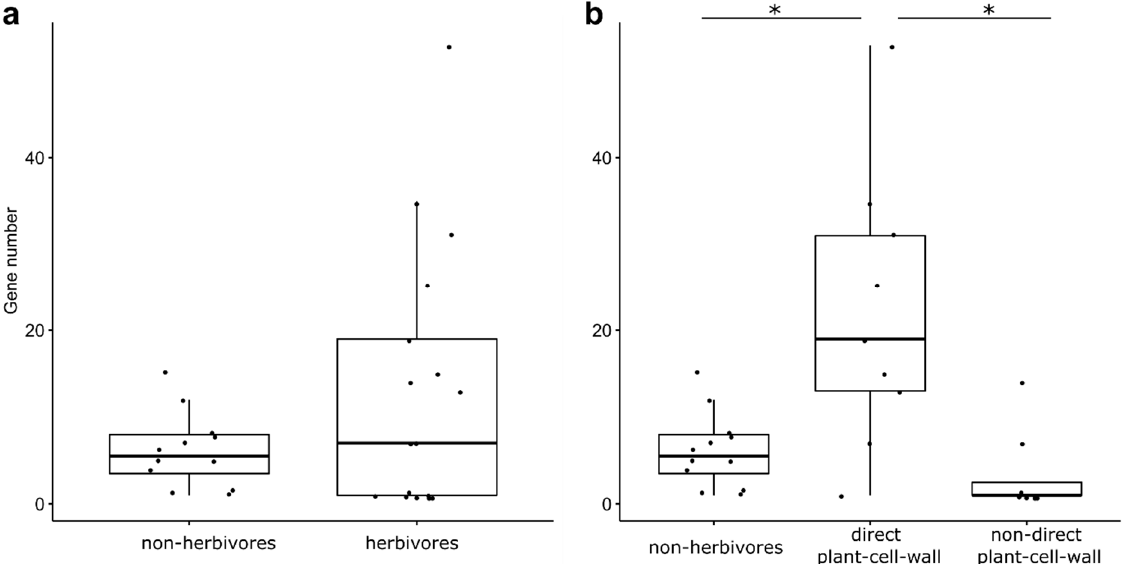
Figure 2. The GH1 gene numbers in each insect order.